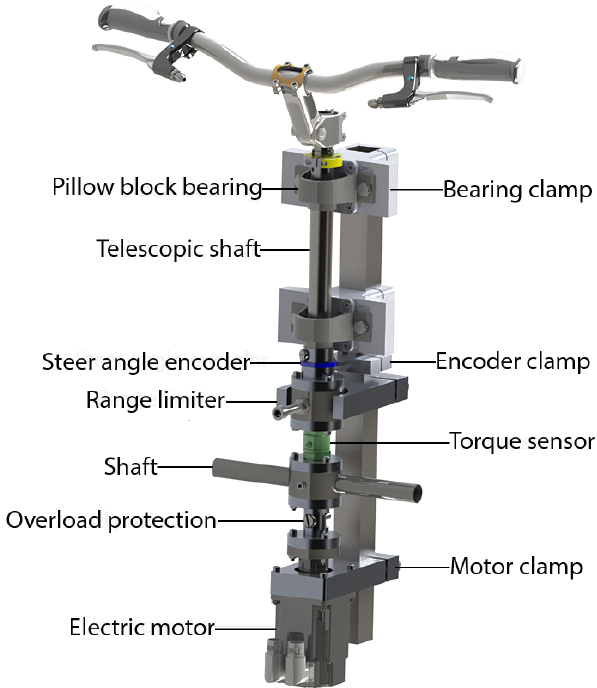
Figure 4. Steering column and shaft assembly exported from solid- works